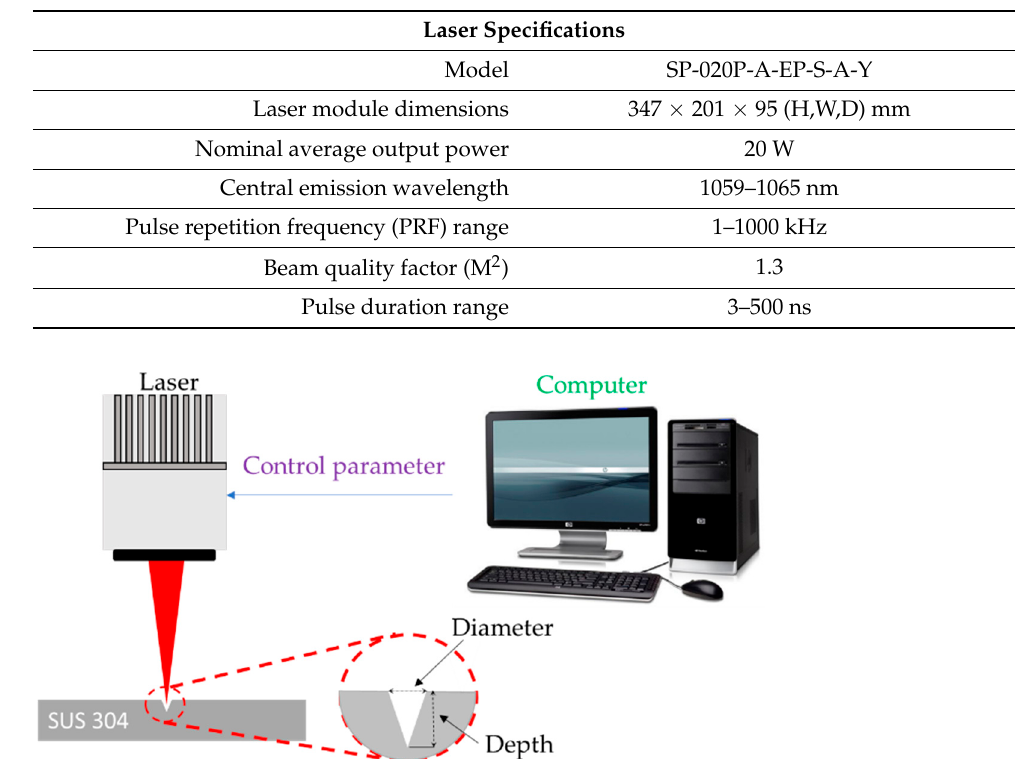
Table 1. Laser source information.